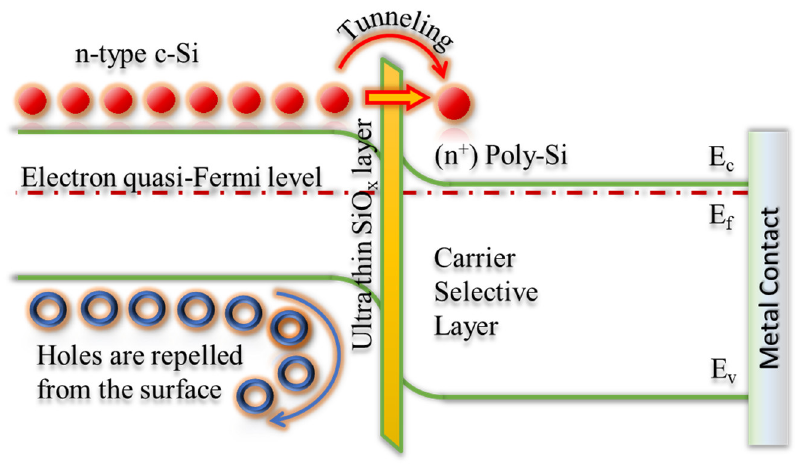
Figure 4. Demonstration of TOPCon solar cell energy band chart with the tunnel oxide carrier transportation [14,55].